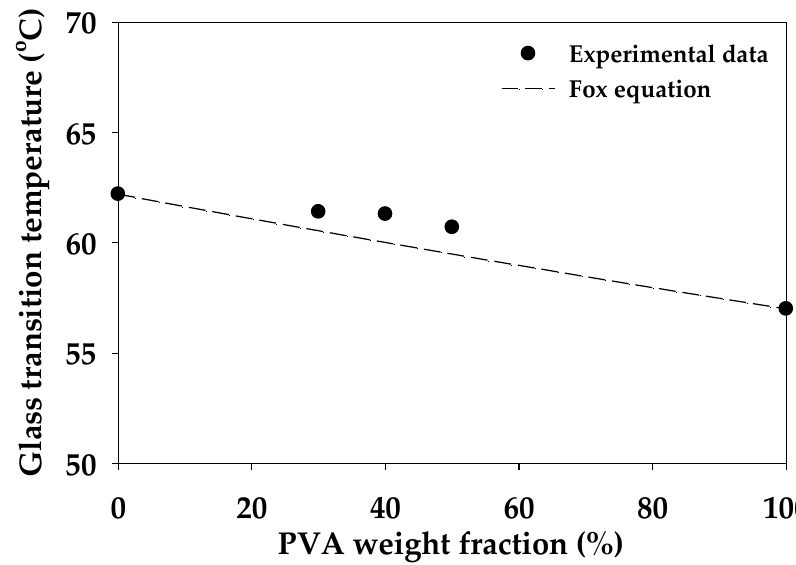
Figure 14. Relation between PVA weight fraction and T g of PLA, PVA, and their blends. The degree of crystallinity (X c ) of the sheet sample was characterized at the edge and core, to observe the e ff ect of etched PVA on the crystalline content. The injected sheet of pure PLA ◦ samples was subjected to the water-etching process at 35 C for 7 days and denoted as PLA7. PLA7 at the edge (PLA7E) and core (PLA7C) contained the PLA crystalline content of 12.4%